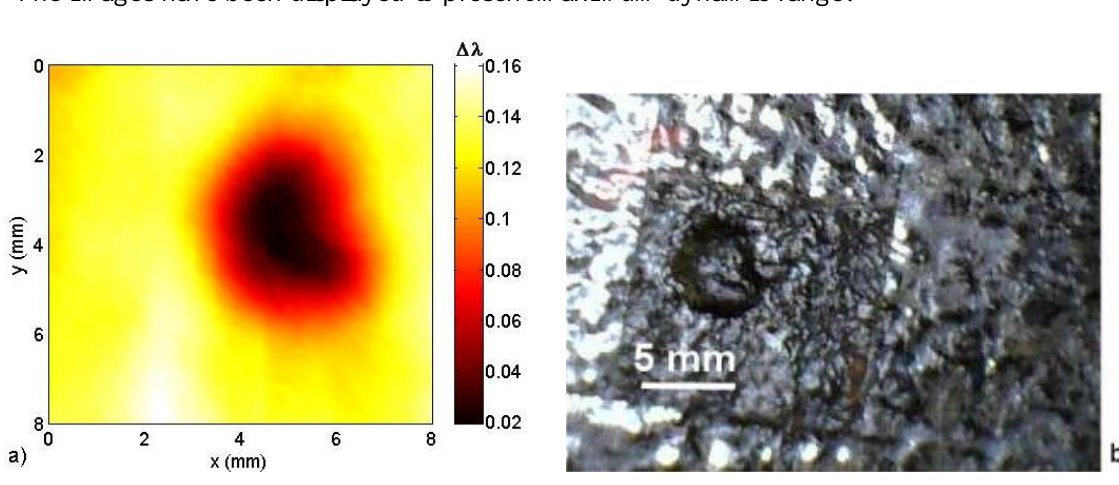
Figure 12. ( a ) Image obtained by scanning a natural corrosion pit under sensor B; ( b ) The natural corrosion pit is 0.4 mm deep; ( c ) Image obtained by scanning an extended corrosion area under sensor B; ( d ) Extended corrosion area. The largest depth in the area is 0.7 mm. The images have been displayed to present maximum dynamic